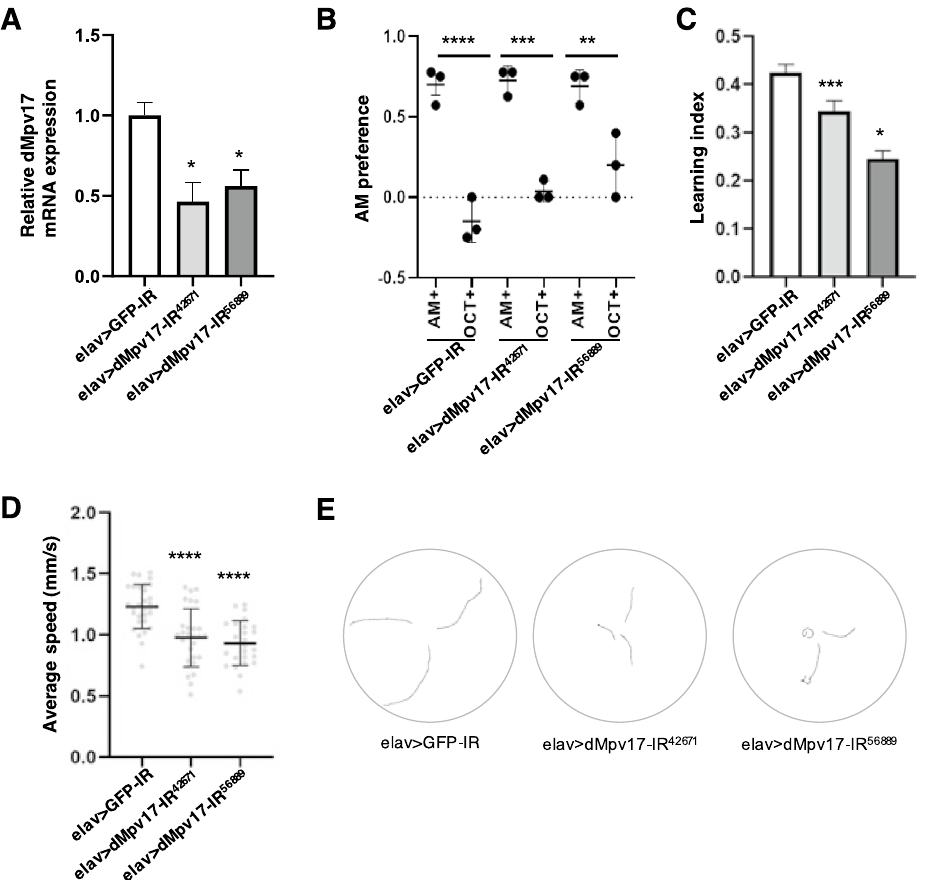
Figure 2. Neuron-specific dMpv17 knockdown larvae show neurological-defect phenotypes. ( A ) Total RNA was extracted from the CNS of third instar larvae carrying elav > GFP-IR ( UAS-GFP-IR/ + ; elav-GAL4/ + ; +), elav > dMpv17-IR 42671 ( elav-GAL4/UAS-dMpv17-IR 42671 ; +), and elav > dMpv17-IR 56889 ( elav-GAL4/UAS- dMpv17-IR 56889 ; +). The mRNA levels of dMpv17 and G6PD in each strain were detected by qRT-PCR. G6PD was used as an internal control. *** P < 0.01, statistical analysis was performed using one-way ANOVA followed by Dunnett’s multiple comparisons test vs elav > GFP-IR. n = 3. ( B , C ) The learning ability of larvae carrying elav > GFP-IR, elav > dMpv17-IR 42671 , and elav > dMpv17-IR 56889 was tested in the odor-taste learning assay. AM preference ( B ) and larval learning index ( C ) were quantified. * P < 0.05, *** P < 0.001, using one-way ANOVA followed by Dunnett’s multiple comparisons test vs elav > GFP-IR. n = 3. ( D , E ) Larval locomotor ability was tested in the crawling assay with elav > GFP-IR, elav > dMpv17-IR 42671 , and elav > dMpv17-IR 56889 . ( D ) The average crawling speed was quantified. Statistical analysis was performed using one-way ANOVA followed by Dunnett’s multiple comparisons test vs elav > GFP-IR. n = 25–31. ( E ) Typical trajectories of larvae with each